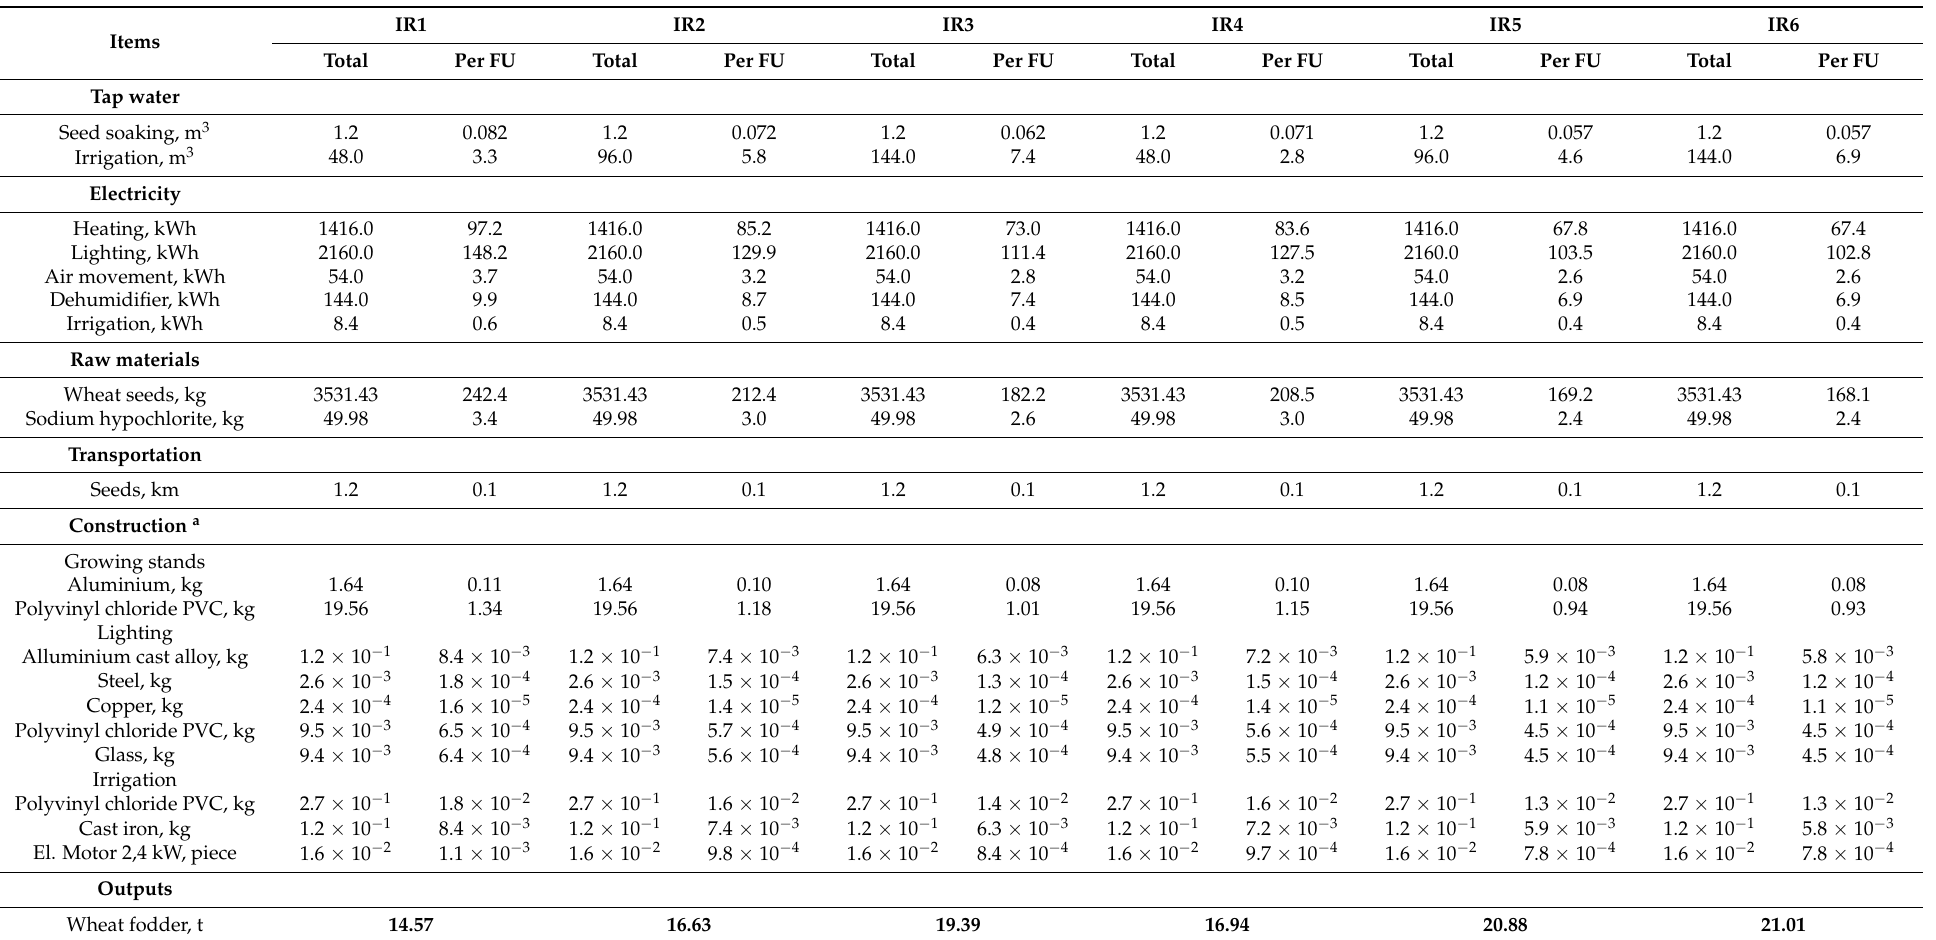
Table 3. Life cycle inventory of a hydroponic system operating for 30